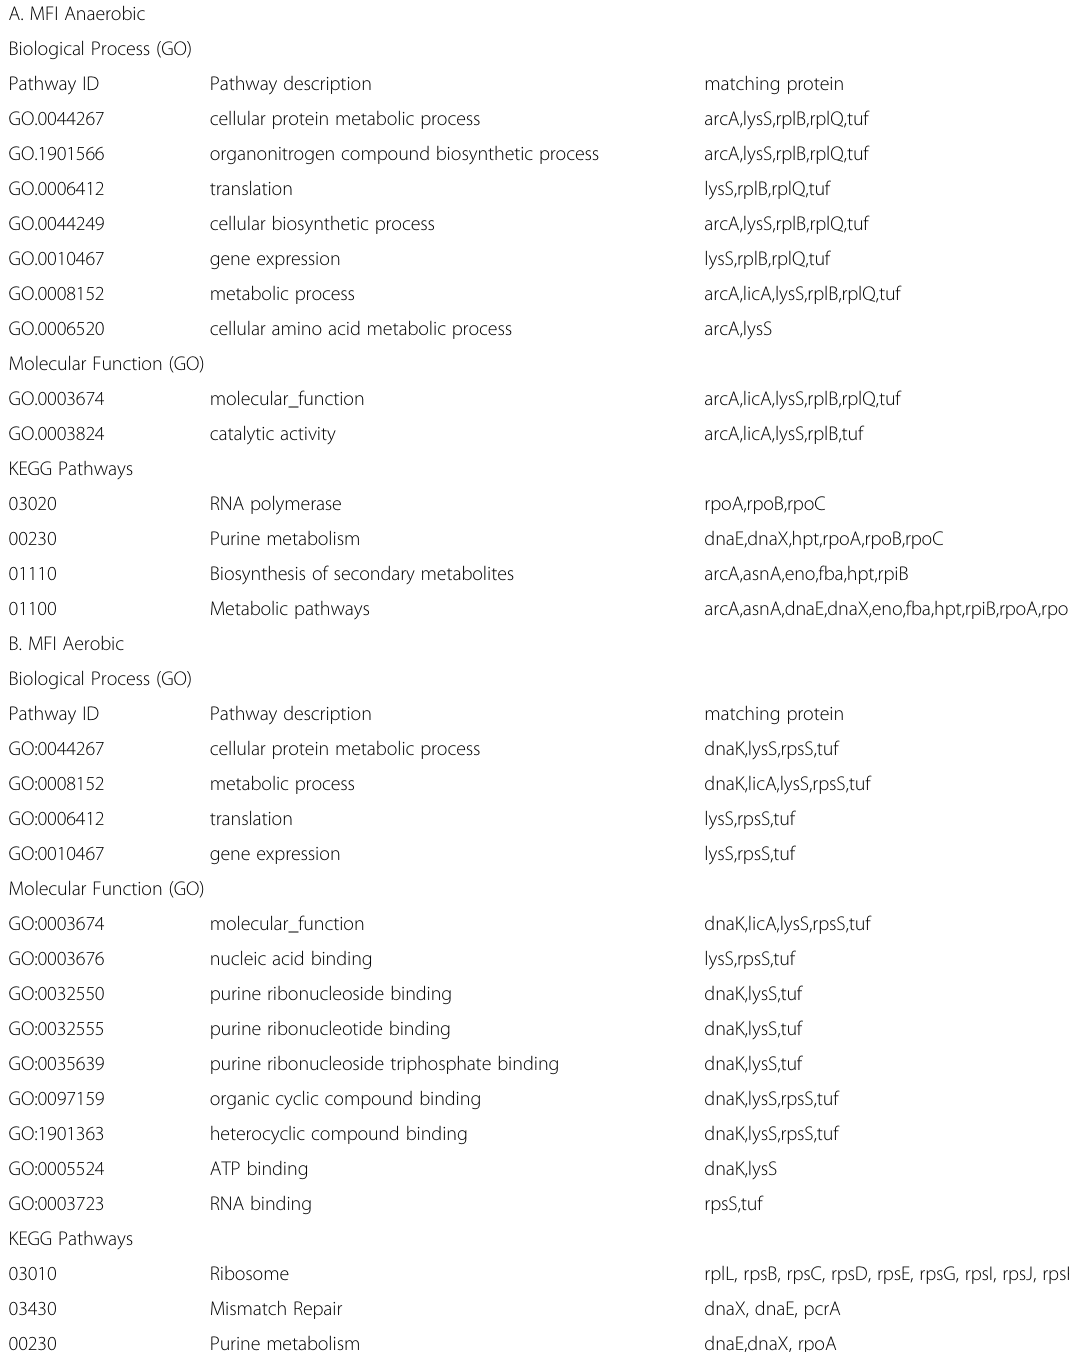
Table 4 Characteristics of biological process, molecular function and KEGG pathways of protein – protein interaction of anaerobic and aerobic Mycoplasma Fermentans with STRING